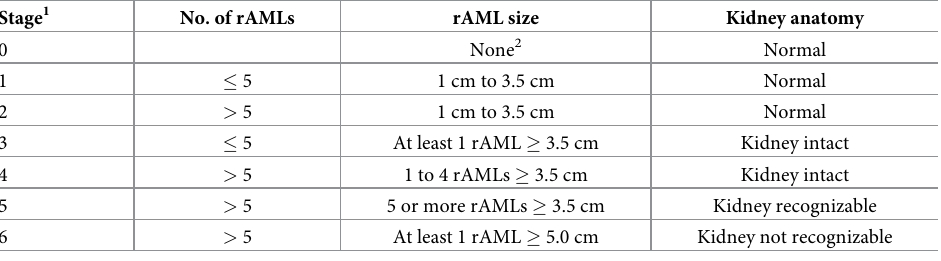
rAML: renal angiomyolipoma. 1 All three conditions need to be